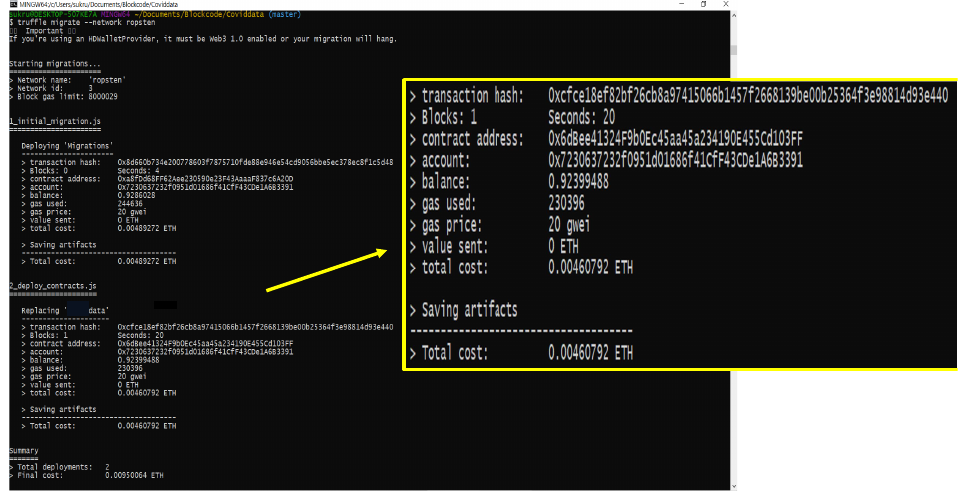
Figure 10. Performance Test for Public Blockchain.